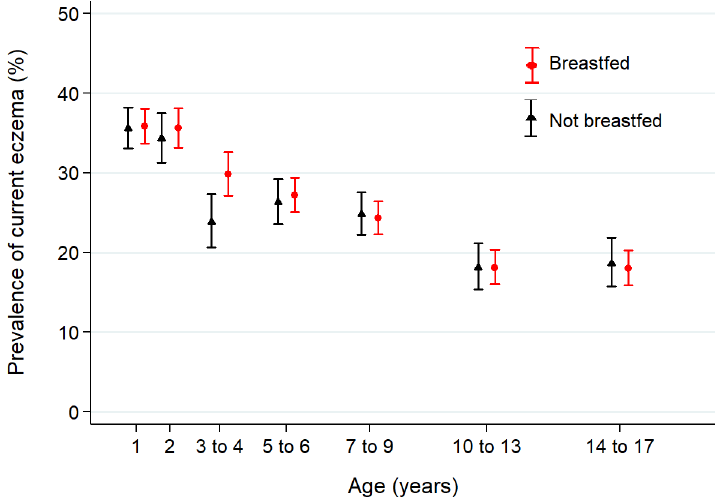
Fig 1. Prevalence of current eczema during childhood and adolescence, by breastfeeding status.